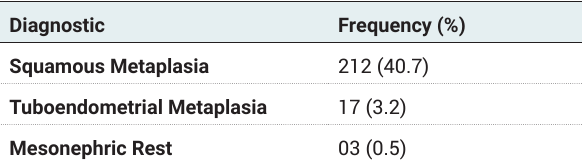
Table 6: Prevalence of various disease conditions in Metaplasia and Ectopies